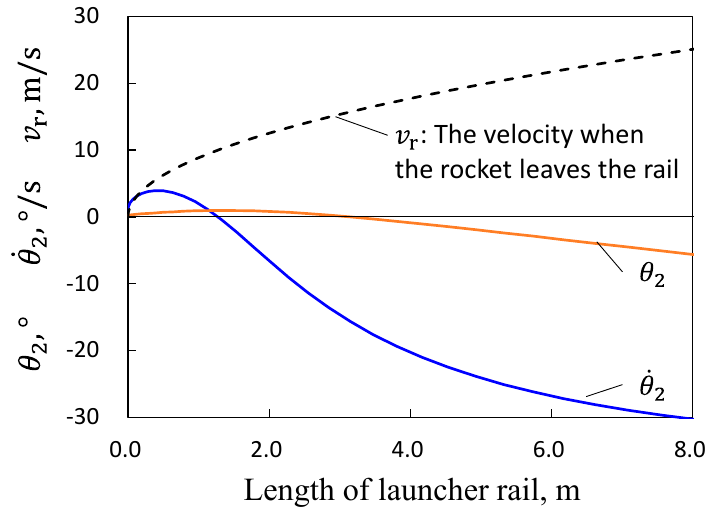
Figure 11. The conditions when the rocket leaves the rail and length of launcher rail.